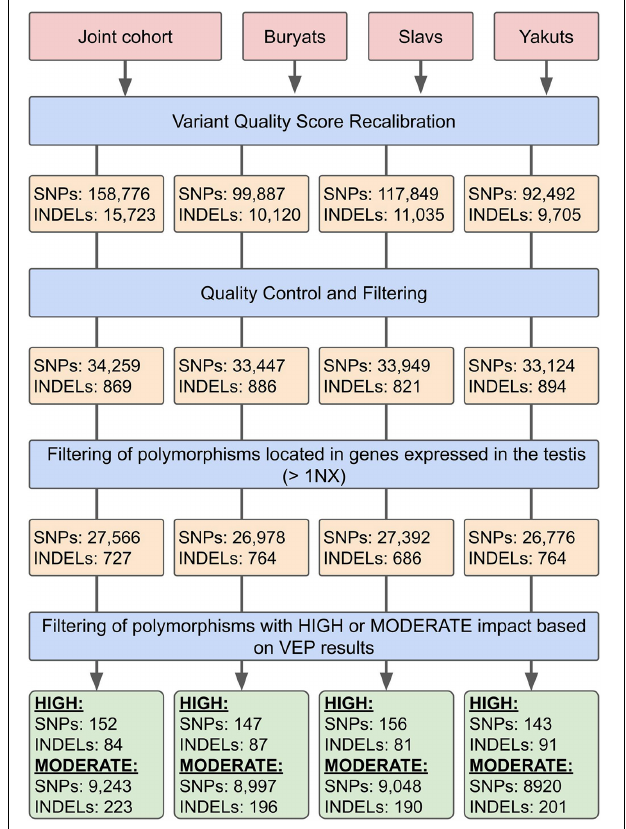
FIGURE 1 | Whole-exome genotype data filtering